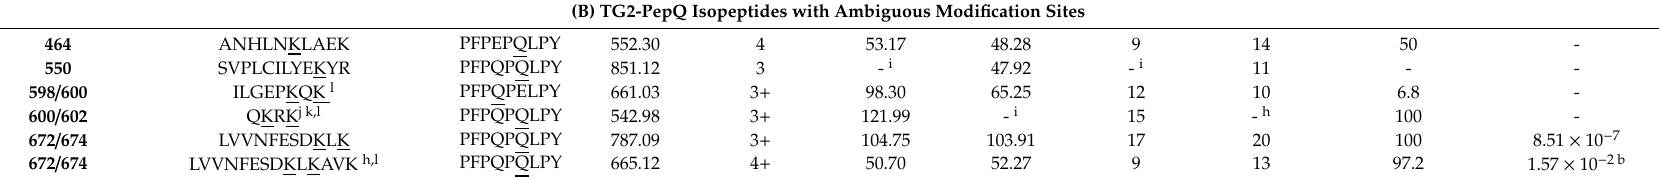
(B) TG2-PepQ Isopeptides with Ambiguous Modification